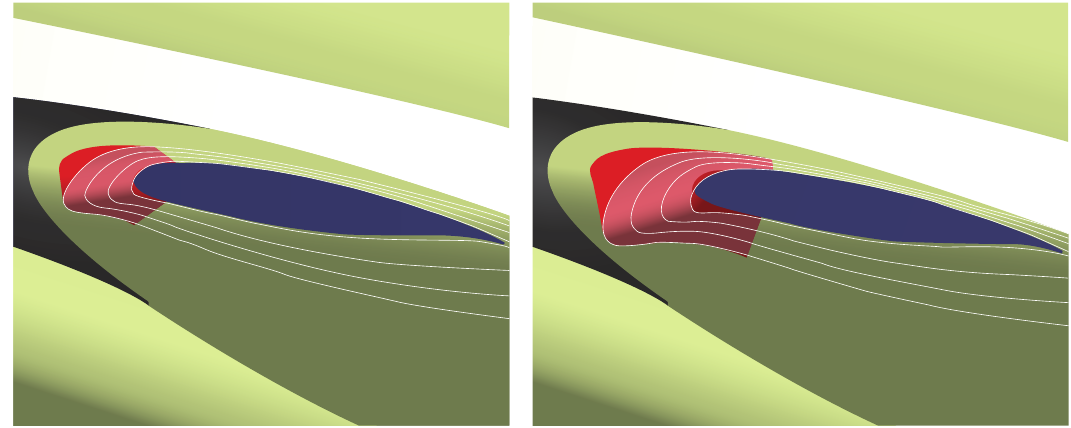
Figure 15: Parametric CAD model of the 10 % and 20 % chordwise morphing leading edge for maximum droop angle under skin structural constraint.